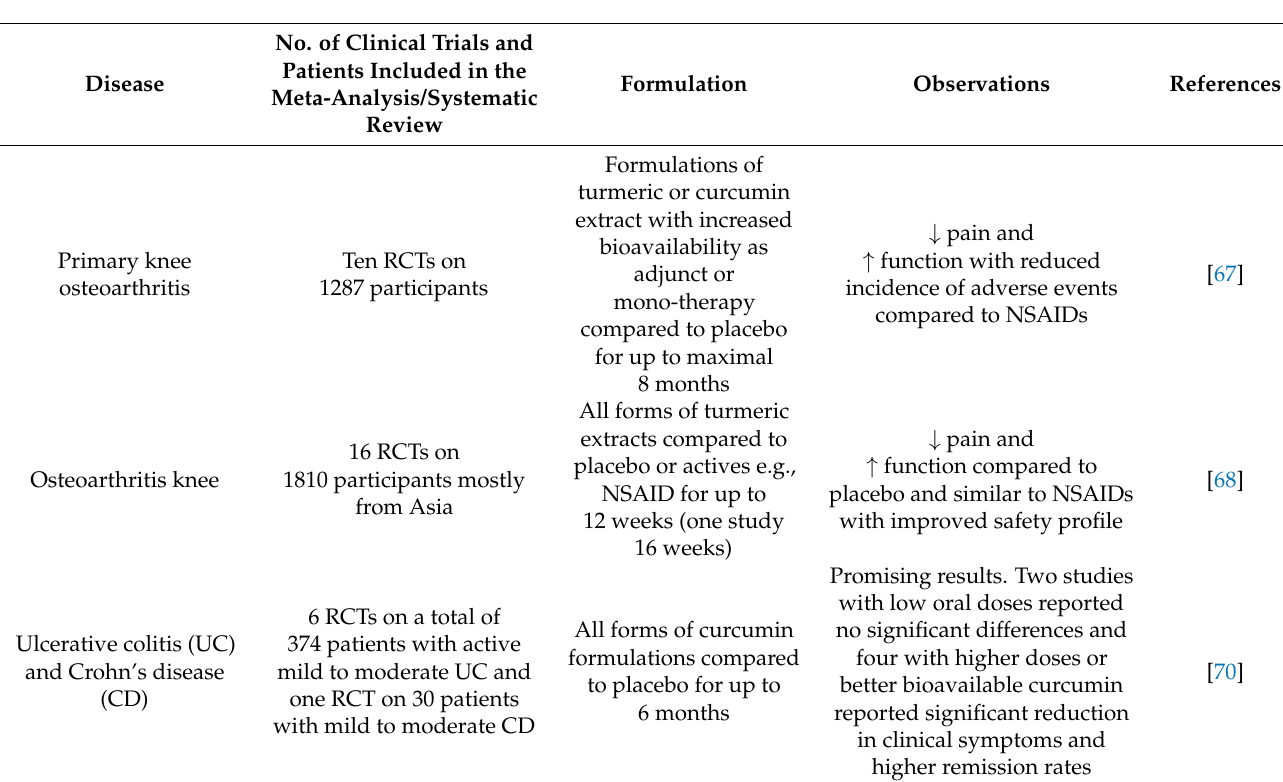
Table 3. An excerpt of recent meta-analyses and systematic reviews addressing the efficacy of curcumin in different diseases associated with inflammation.